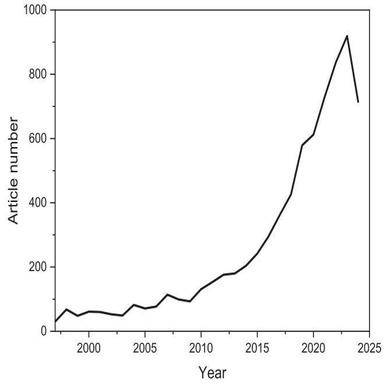
Annual scientifical productions on fatigue of cementitious materials.